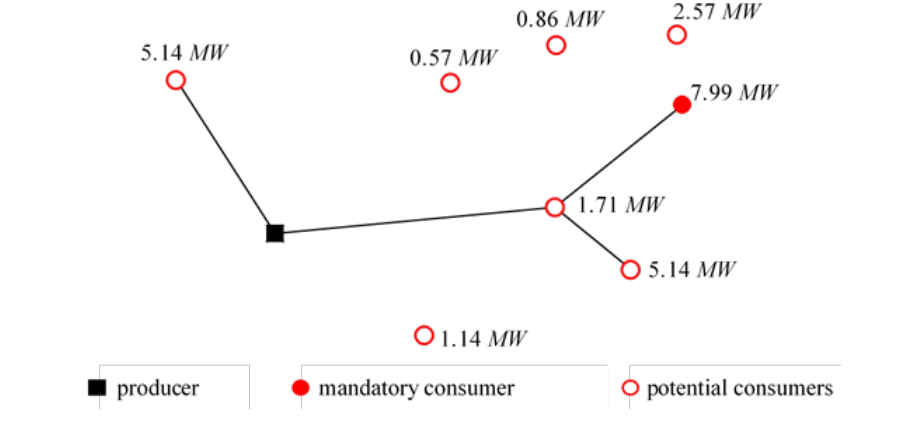
Figure 5. DHN topology for max 𝑃𝑟𝑜𝑓𝑖𝑡 .